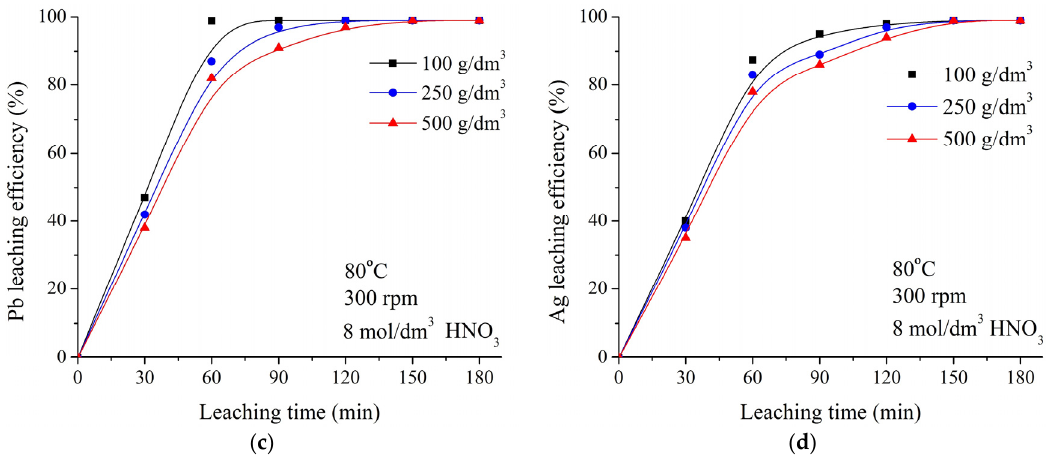
Figure 7. Influence of various process parameters on Pb and Ag leaching efficiency: ( a ) HNO 3 concentration; ( b ) leaching time; ( c ) S/L ratio on Pb leaching efficiency; ( d ) S/L ratio on Ag leaching efficiency.